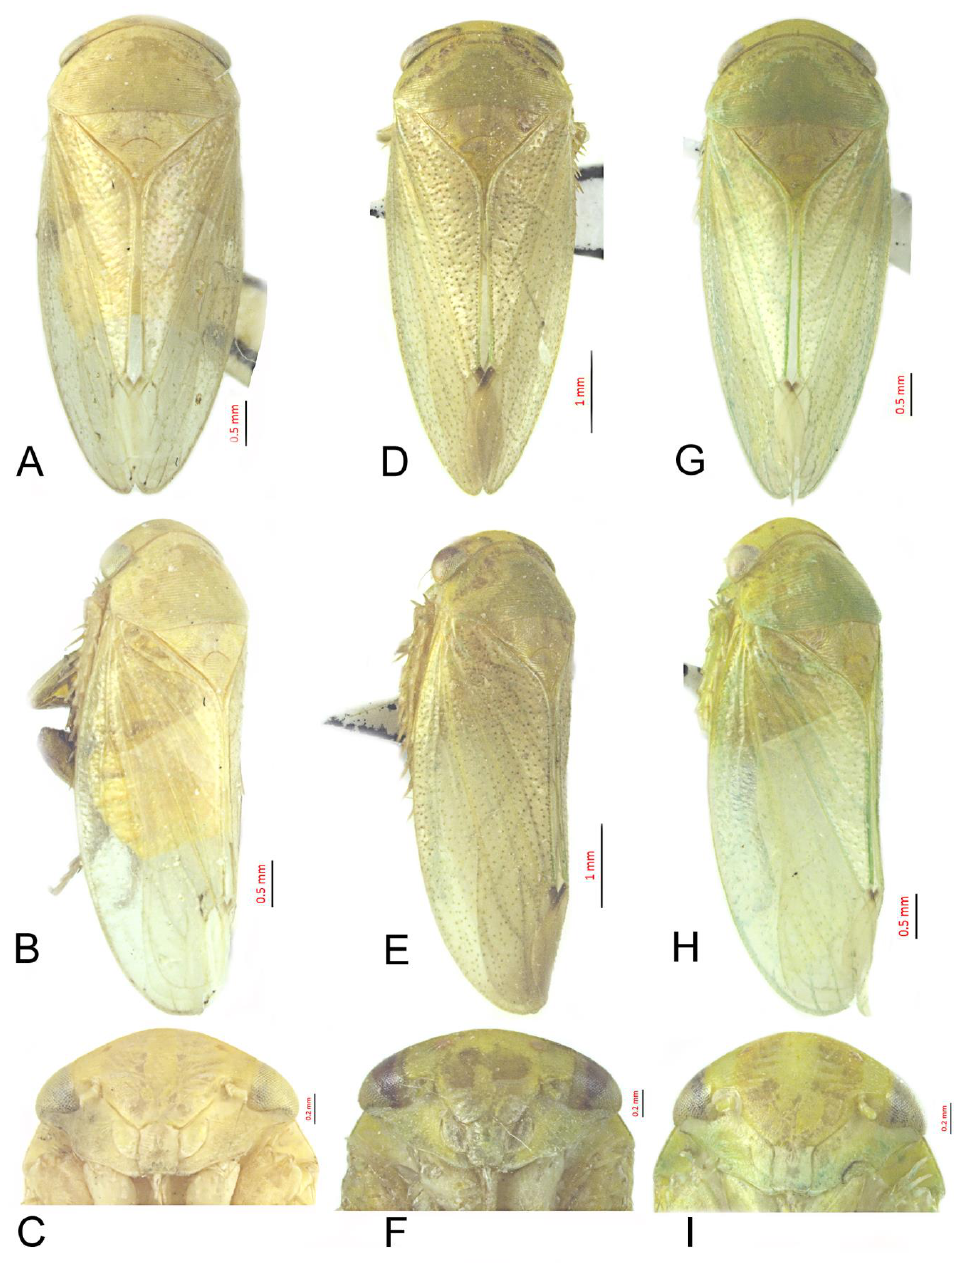
Figure 4. Batracomophus c lavatus Cai and Shen, 2010: ( A ) habitus, ventral view, ( B ) habitus, lateral view, ( C ) face; Batracomorphus lunatus Cai and He, 2001: ( D ) habitus, ventral view, ( E ) habitus, lateral view, ( F ) face; Batracomorphus geminatus (Li and Wang, 1993): ( G ) habitus, ventral view, ( H ) habitus, lateral view, ( I ) face.